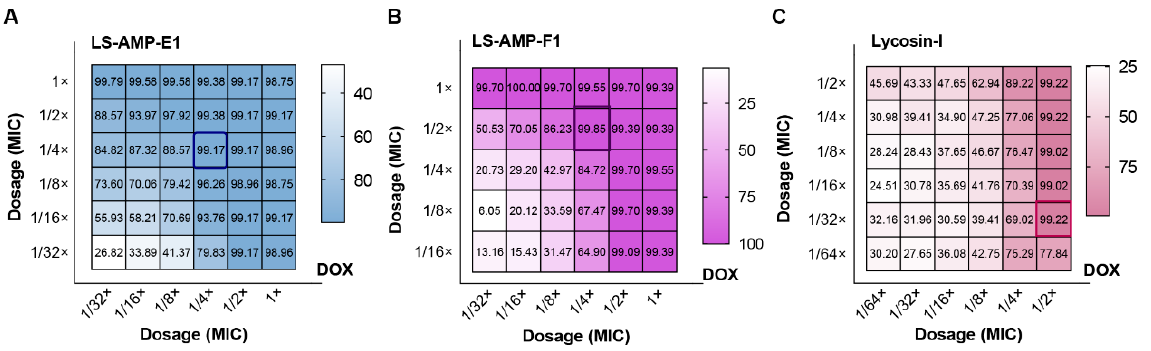
Figure 4. Inhibition rate of the checkerboard test for MDR A. baumannii (1055). ( A ), the combination of LS-AMP-E1 and DOX; ( B ), the combination of LS-AMP-F1 and DOX; ( C ), the combination of Lycosin-I and DOX. The dosage was indicated by the dilution multiple of MIC (antibiotic or peptides alone).